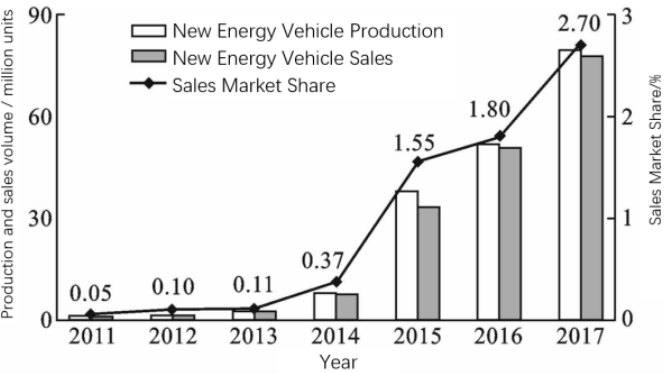
Figure 1. China’s new energy vehicle production and sales from 2011 to 2017.